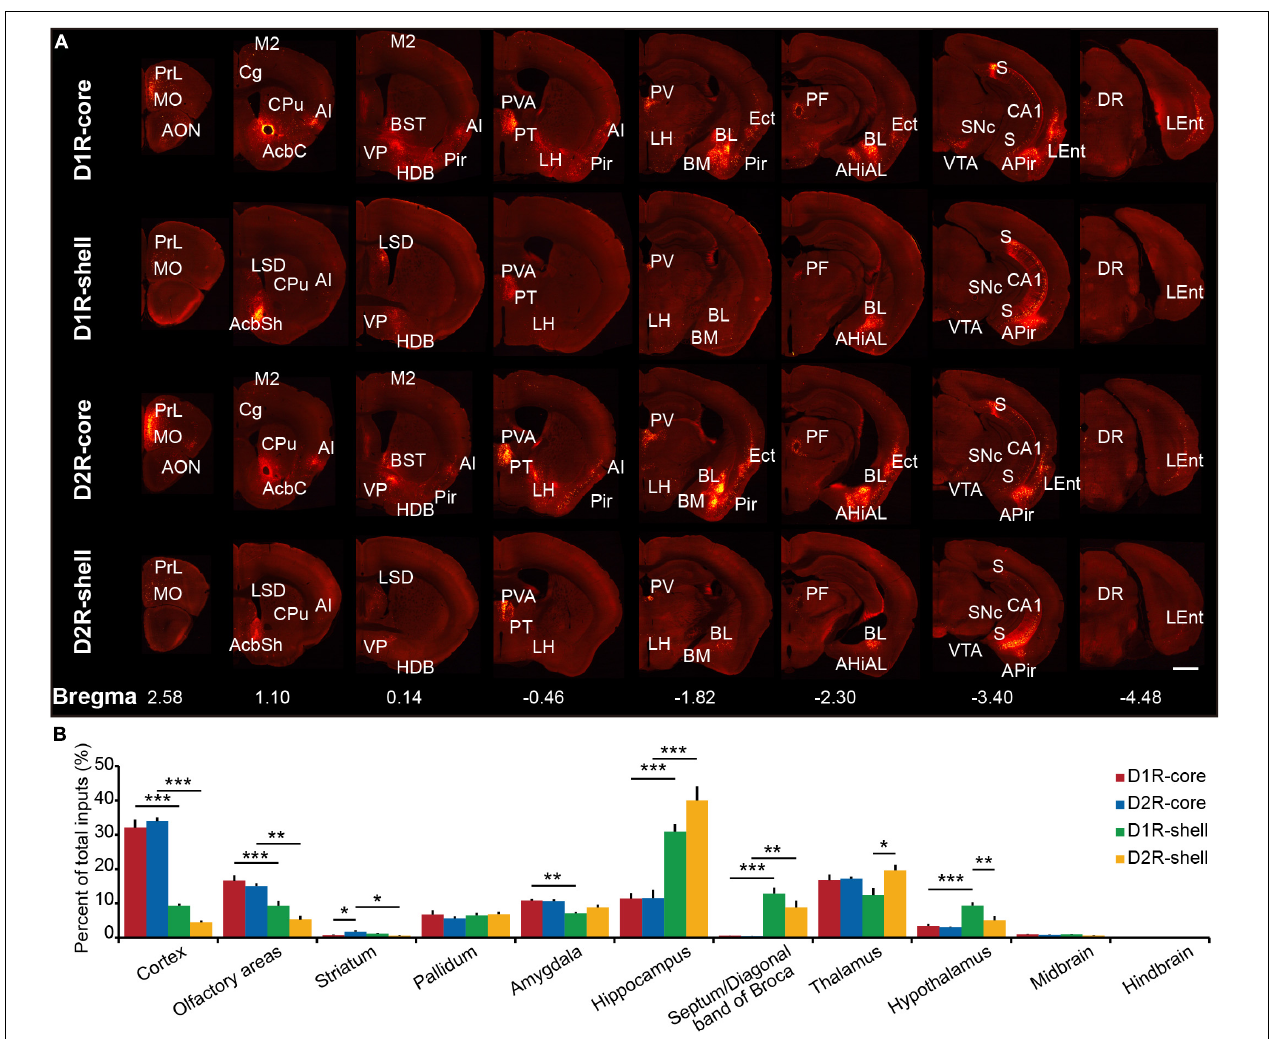
FIGURE 3 | Overview of whole brain input to D1R-MSNs and D2R-MSNs in different NAc subregions. (A) Representative coronal sections showing labeling of monosynaptic inputs to D1R-core, D1R-shell, D2R-core, and D2R-shell neurons. Only the side ipsilateral to the injection site is shown. Scale bar, 1 mm. (B) Proportions of total inputs from 11 brain areas. Mean ± SEM ( n = 6 mice each for the D1R-core, D1R-shell, D2R-core, and D2R- shell groups). ∗∗∗ p < 0.001, ∗∗ p < 0.01, and ∗ p < 0.05. Only significant differences between the same cell type in different subregions or between different cell types in the same subregions are marked; one-way ANOVA with Bonferroni